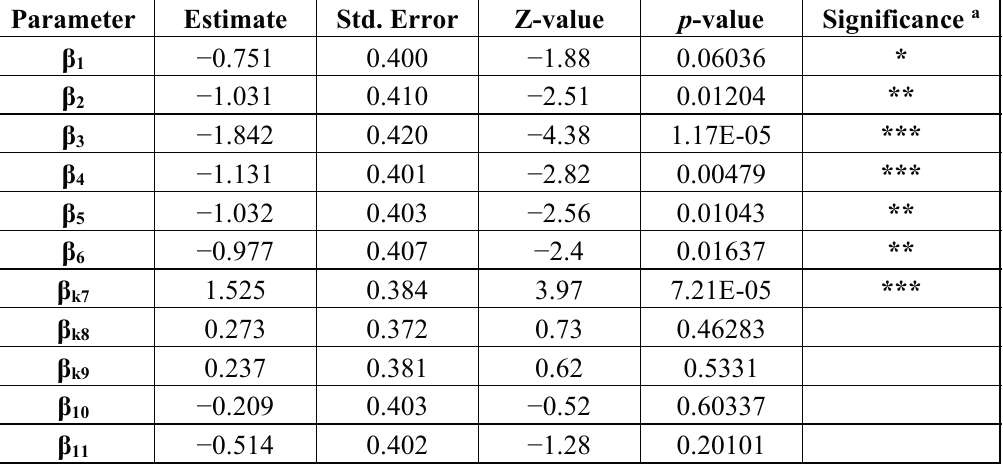
Table 4. Parameters for variation of QOL from over-all QOL.